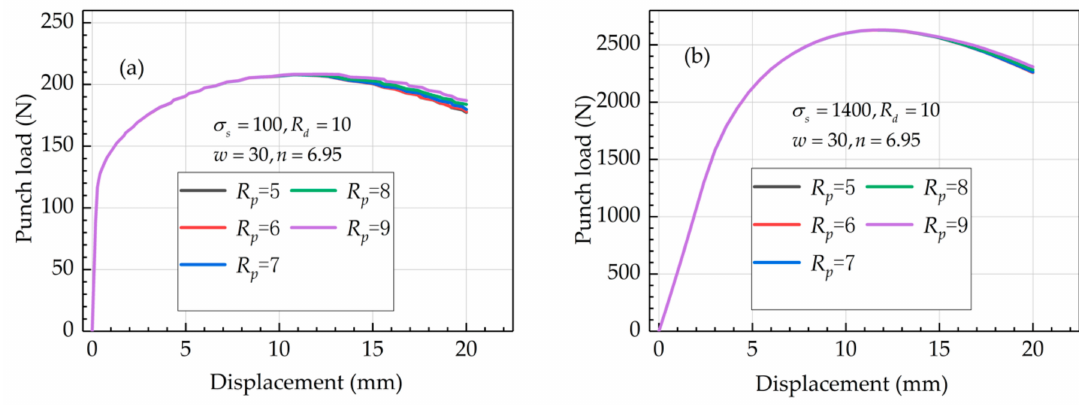
Figure 5. Stroke curve of bending force under di ff erent punch fillets: ( a ) MYL; ( b )